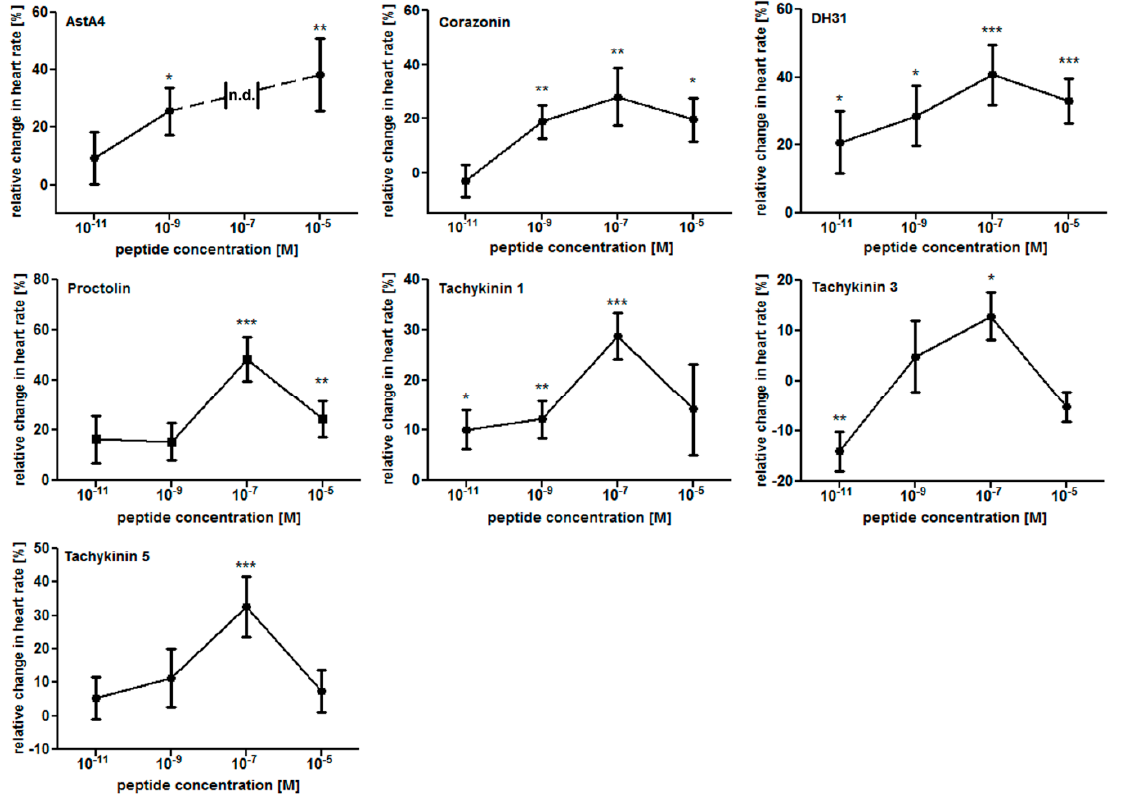
Figure 2. Dose–response curves for the effects of chronotropic peptides in semi-intact Drosophila larvae. Individual effects of the tested peptides at 1 × 10 − 11 M, 1 × 10 − 9 M, 1 × 10 − 7 M, and 1 × 10 − 5 M are shown. Data are presented as mean values (± S.E.M.) of the relative changes in heart rate in relation to the individual control preparations (prior to peptide application). A minimum of ten animals per